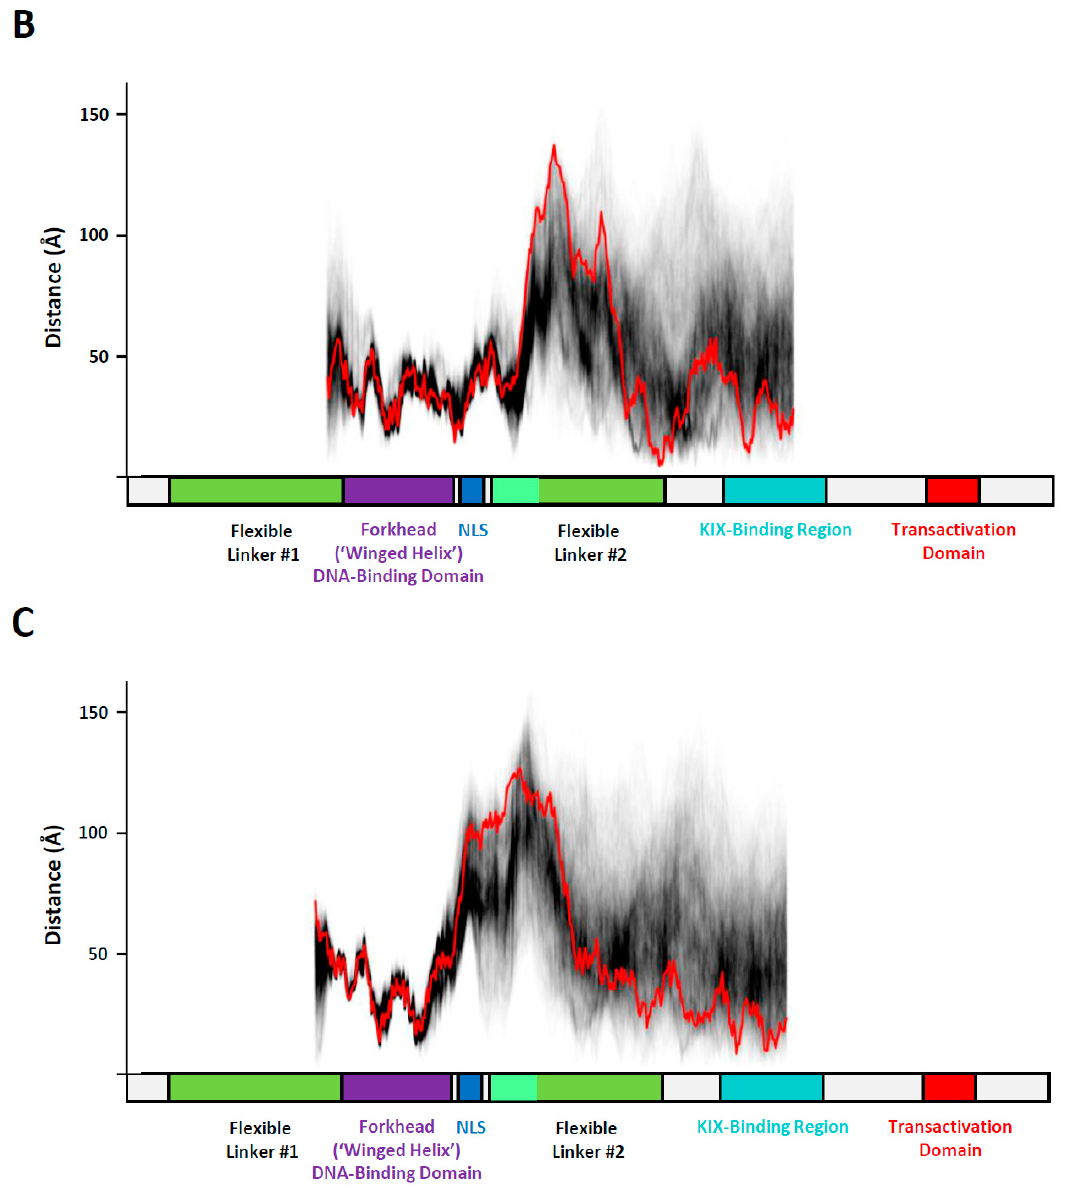
Figure 5. Local compaction plots (LCPs) of FOXO3 molecular dynamics (MD) simulation data. ( A ) LCP analysis of the FOXO3 MD simulation data. The sliding window size for the intramolecular distance measurements is fixed at 75 amino acids. The distance (in Å) between the residues at position 1 and 75 of the window is determined using cpptraj (AMBER simulation package; [32]) for all snapshots of the trajectories. The window is then moved to a new position shifted by one residue. The FOXO3 DNA-binding domain (residues 157 to 237, shown as a purple box) is stably folded and therefore all distance measurements within (and immediately adjacent to it) are quite constant, short (<50 Å) and superimposable on each other to form a dense black line. In contrast, the ‘Flexible Linkers’ (FL) are distinctly recognizable in the LCP because of the large distances (50–150 Å) identified in the sliding 75 amino acid windows and their more diffuse appearance due to the presence of alternative conformations. ( B ) LCP of the aMD simulation data of FOXO3 120 − 530 using the final frame of gb8_md#1 containing FL#2-A in a compact conformation. The LCP trace of the starting structure is shown in red and the traces of the aMD simulations reflecting 100 ns in black. ( C ) LCP of the aMD simulation data of FOXO3 120–530 using the final frame of gb8_md#1 containing FL#2-A in an extended conformation. The LCP trace of the starting structure is shown in red and the traces of the aMD simulations reflecting 100 ns in black.